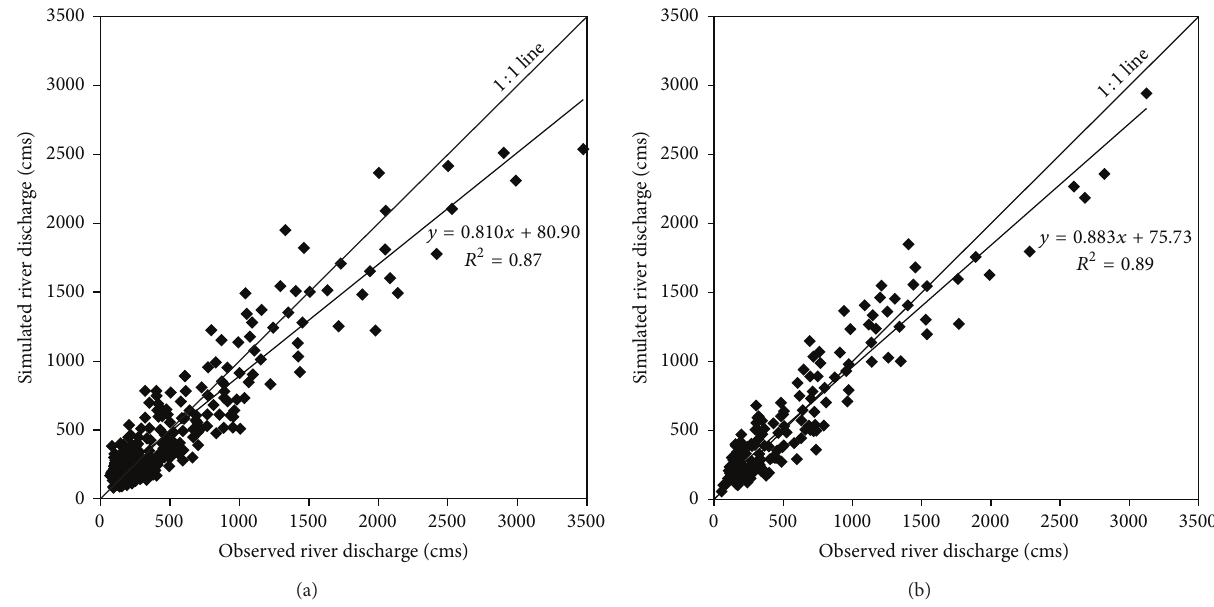
Figure 4: Regression plots of simulated versus observed discharge relative to 1: 1 line for (a) 25-year calibration period (1971–1995) and (b) 15-year validation period (1996–2010).